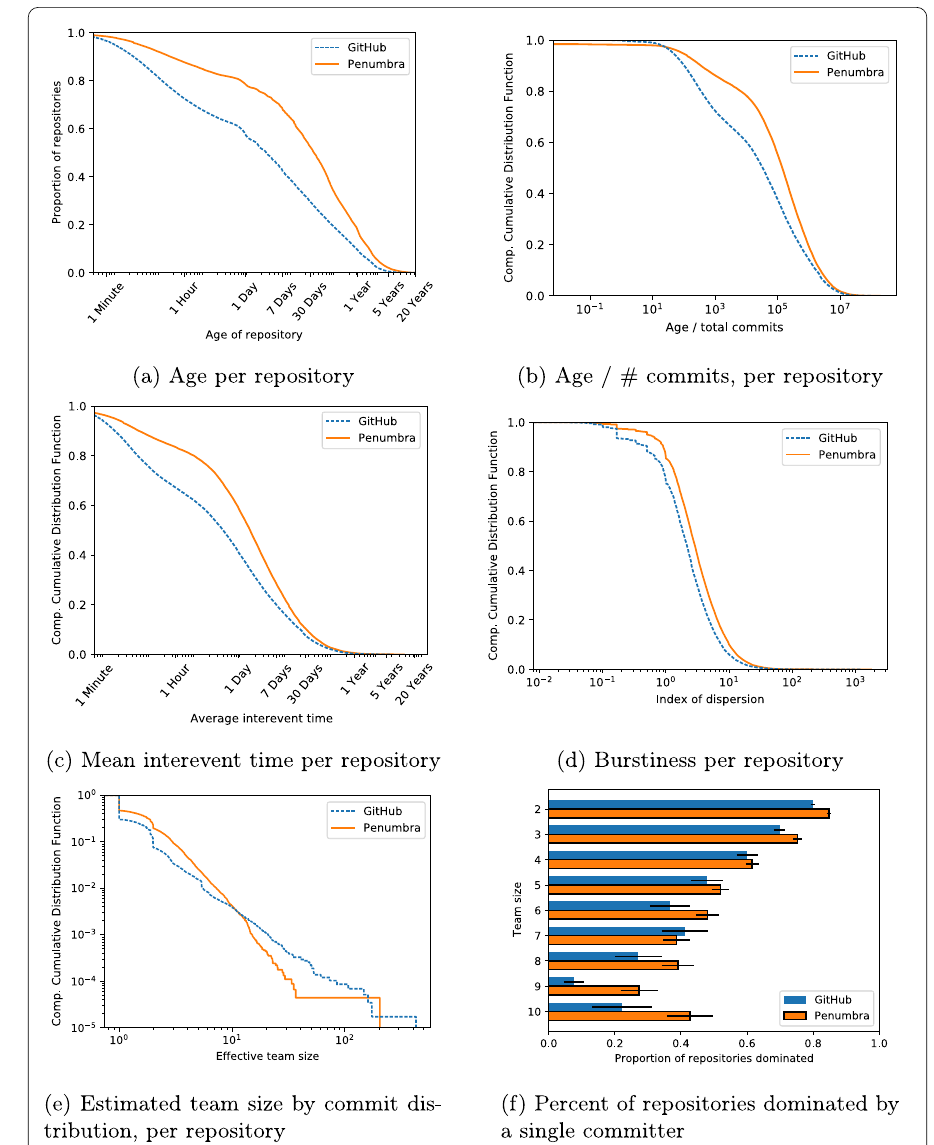
Figure 3 Temporal characteristics of collaboration in the Penumbra and GitHub. Comparison of GitHub and Penumbra samples on a variety of temporal metrics. The age of repository is given by the time between the first and latest commit. Panels ( b - d ) look at the heterogeneity of time between events. We first compare the distribution of mean interevent time to the distribution of ratios of age to number of commits, then show the distribution of index of dispersion per repository. Panels ( e - f ) compare how collaborative repositories actually are, or whether they are dominated by a single